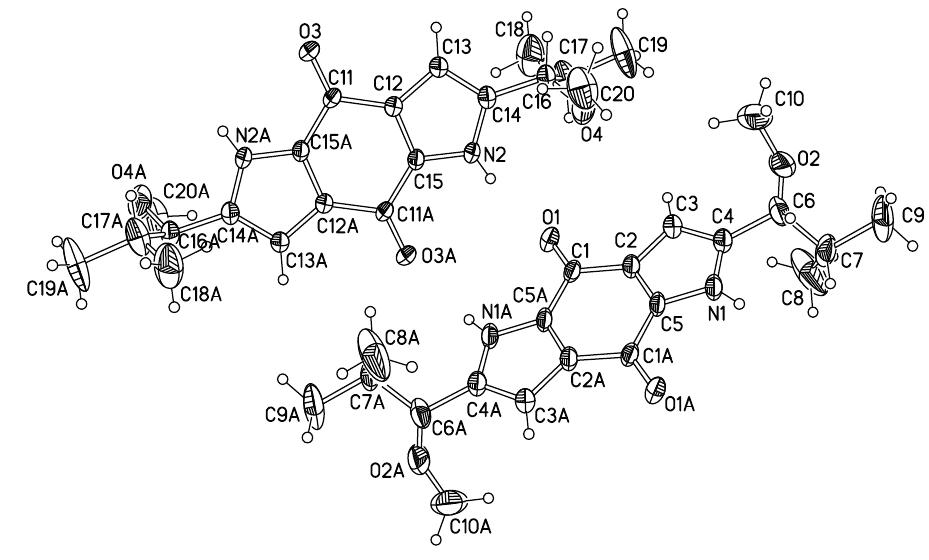
Figure 3. X-ray crystal structure of compound 1